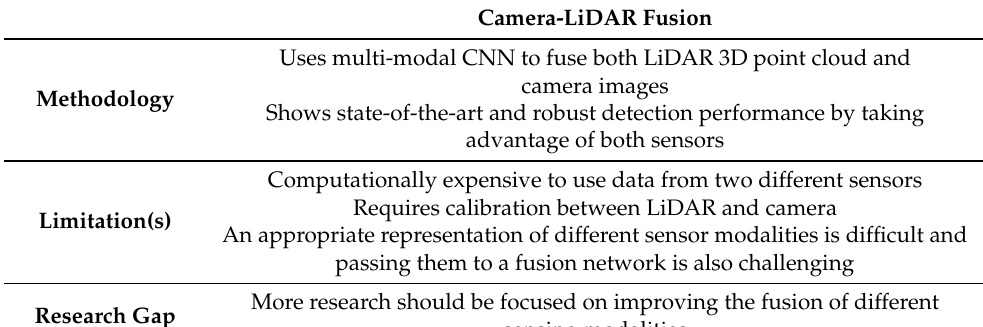
Table 17. Methodology and Limitation(s): Camera-LiDAR fusion-based 3DOR Methods.